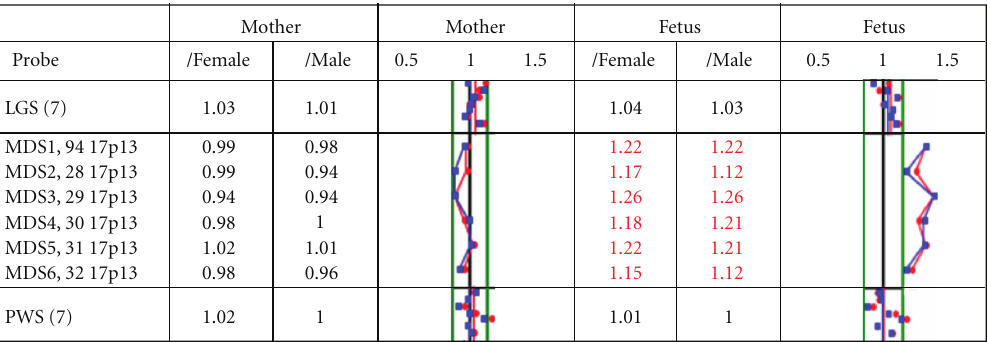
Figure 3: PN BoBs results. The Prenatal BACs-on-Beads-assay (PN BoBs) results show a duplication of all six probes on the Miller-Dieker syndrome (MDS) region of the fetus and a normal result of the